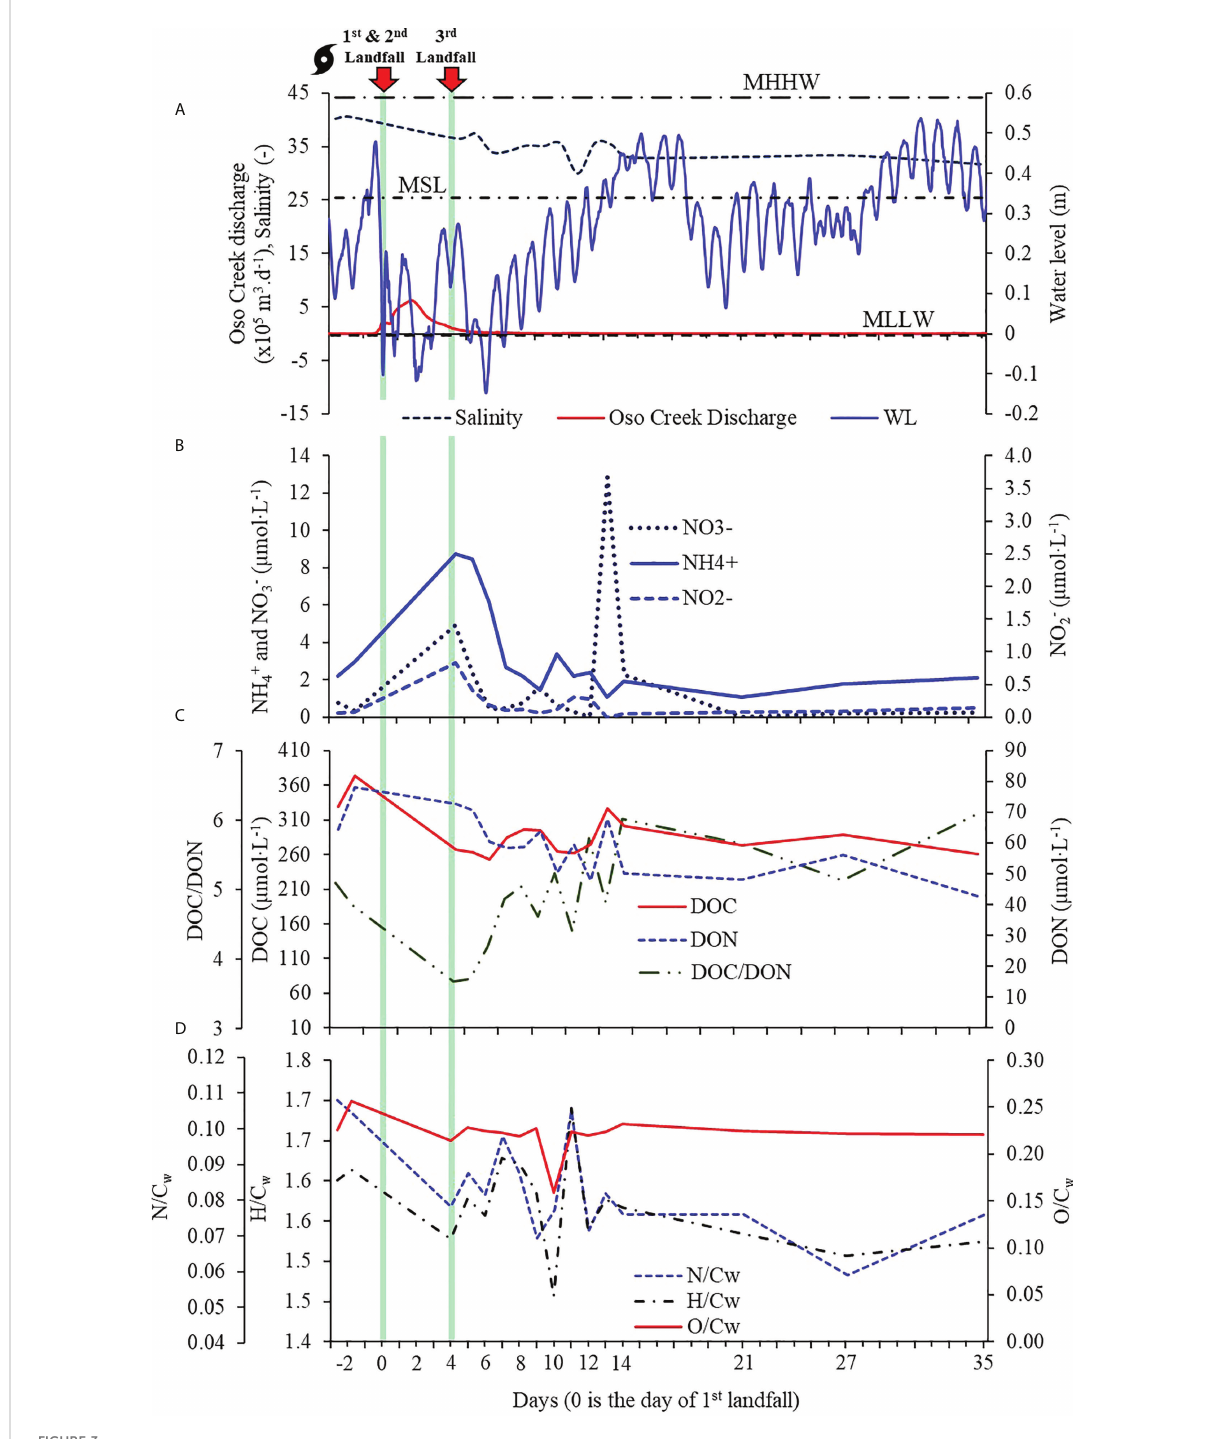
FIGURE 3 Temporal variation of Corpus Christi Bay surface water. (A) Continuous water level, salinity, and Oso Creek discharge with mean higher high- water level (MHHL), mean sea level (MSL), and mean lower low water level (MLLW) shown. (B) Ammonium, nitrate, and nitrite. (C) Dissolved organic carbon (DOC), dissolved organic nitrogen (DON), and C/N ratios. (D) H/C w , O/C w , and N/C w ratios. Hurricane landfalls are indicated by vertical green